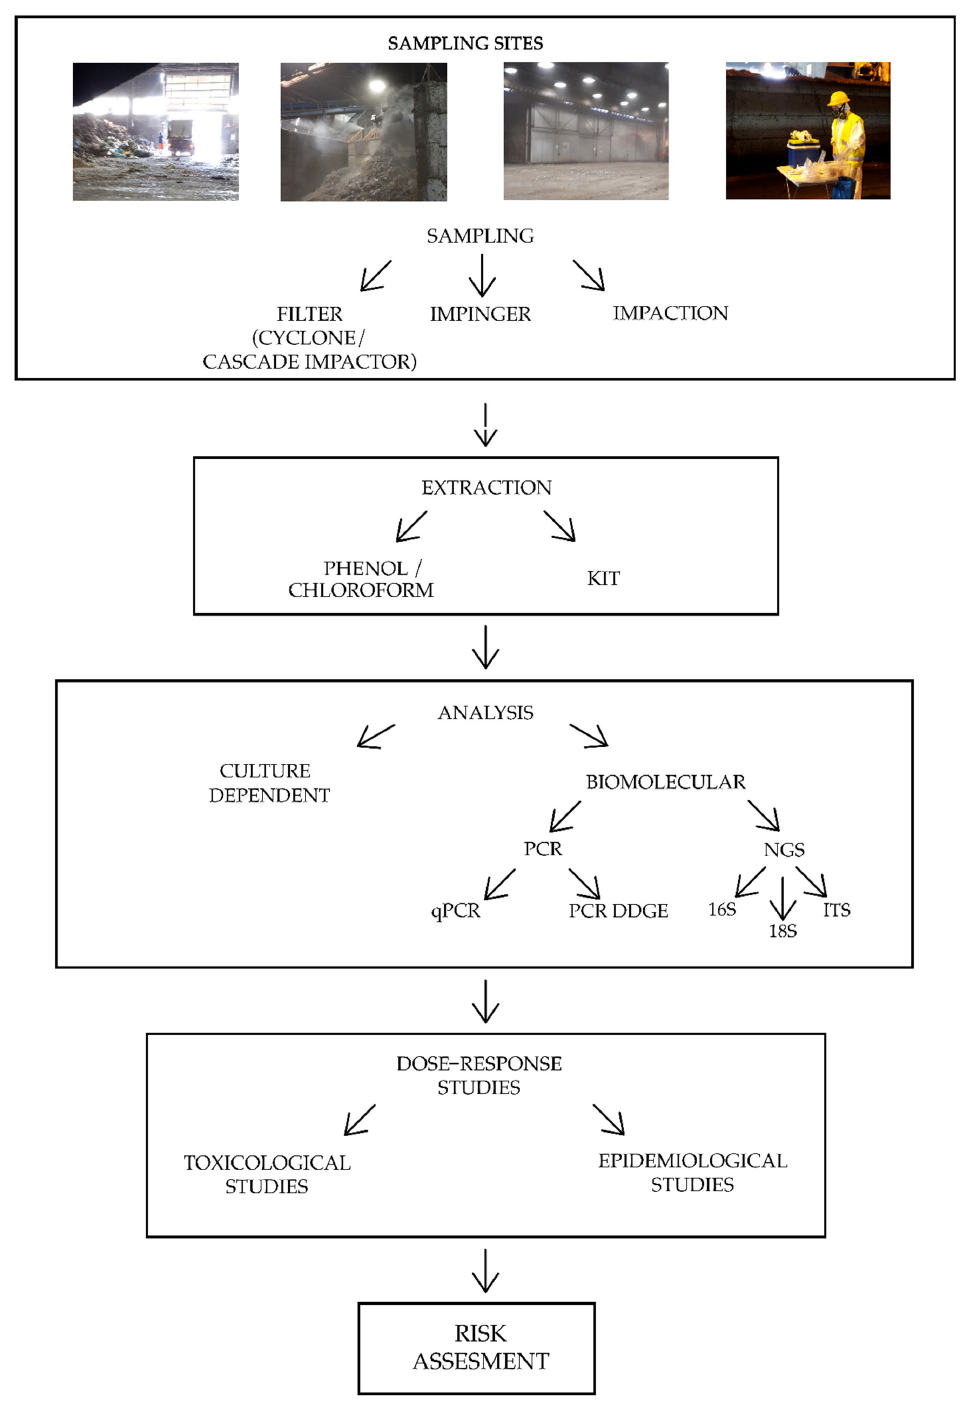
Figure 1. Summary of the main bioaerosol risk assessment steps. The four pictures at the top represent common sampling sites in organic waste treatment plants. Note: PCR = Polymerase Chain Reaction; qPCR = quantitative Polymerase Chain Reaction; PCR DGGE = Polymerase Chain Reaction Denaturing Gradient Gel Electrophoresis; NGS = Next Generation Sequencing; 16 S = ribosomal region 16S of bacteria; 18 S = ribosomal region 18S of fungi; ITS = Internal Transcribed